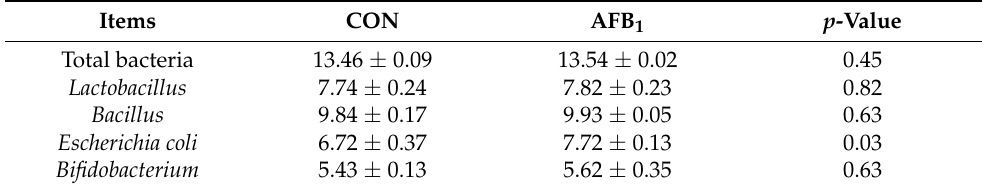
Table 11. Effects of AFB 1 on bacteria populations in colonic digesta of pigs